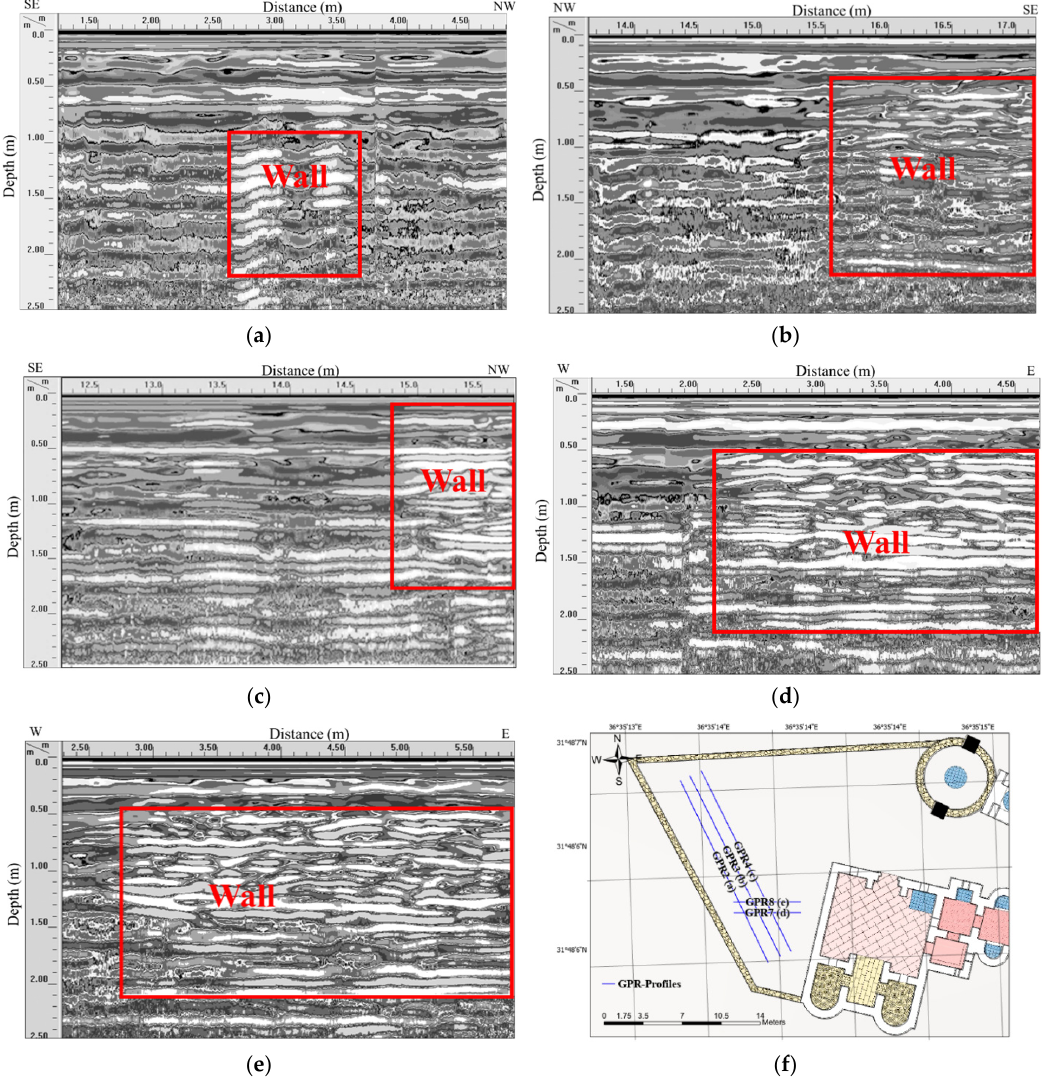
Figure 16. Radar cross-section profile along lines ( a ) GPR2; ( b ) GPR3; ( c ) GPR4; ( d ) GPR7; and ( e ) GPR8; ( f ) location of the GPR